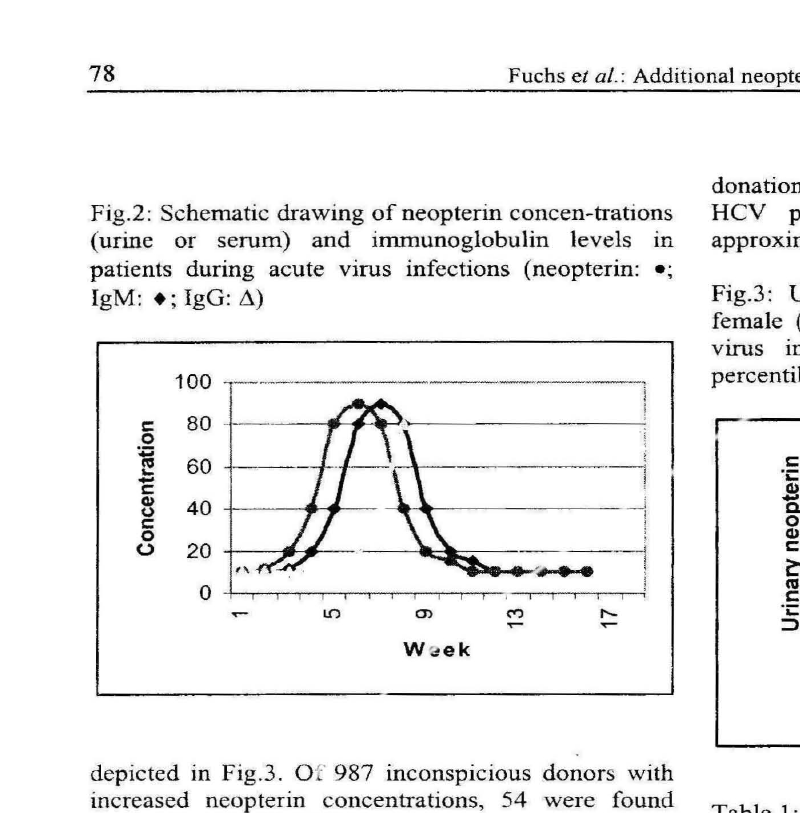
Fig.2: Schematic drawing of neopterin concen-trations (urine or serum) and immunoglobulin levels in patients during acute virus infections (neopterin: e;